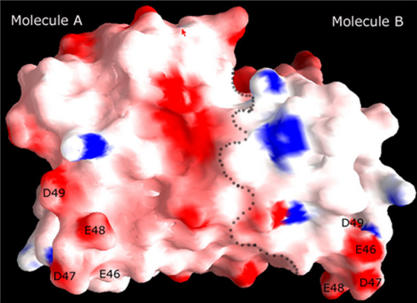
The Electrostatic Surface Potential of GrlR DimerThe surface-exposed (EDED) residues are labeled. It shows a strong negatively charged (red) patch from both EDED motifs of the monomers. The dotted line indicates the dimer interface. Blue represents a positive charge. This figure was prepared using GRASP [20].